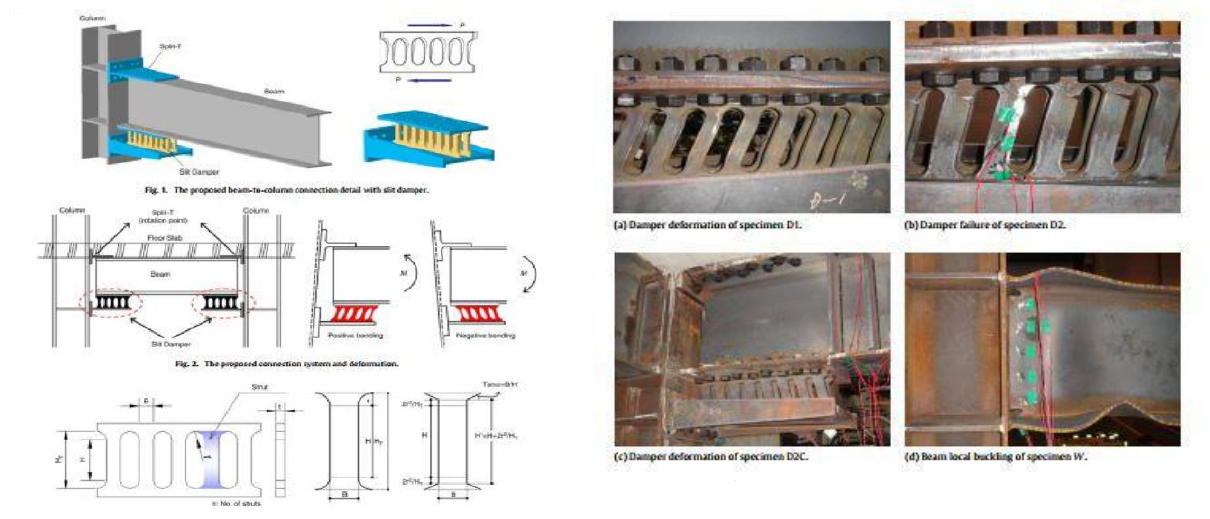
Figure 1. Beam-column connection with slit damper of the test